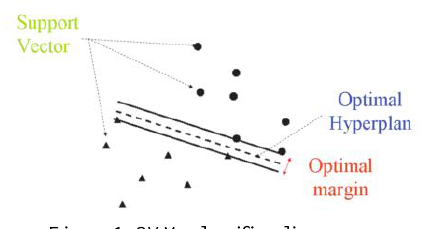
Figure 1. SVM classifier; linear case